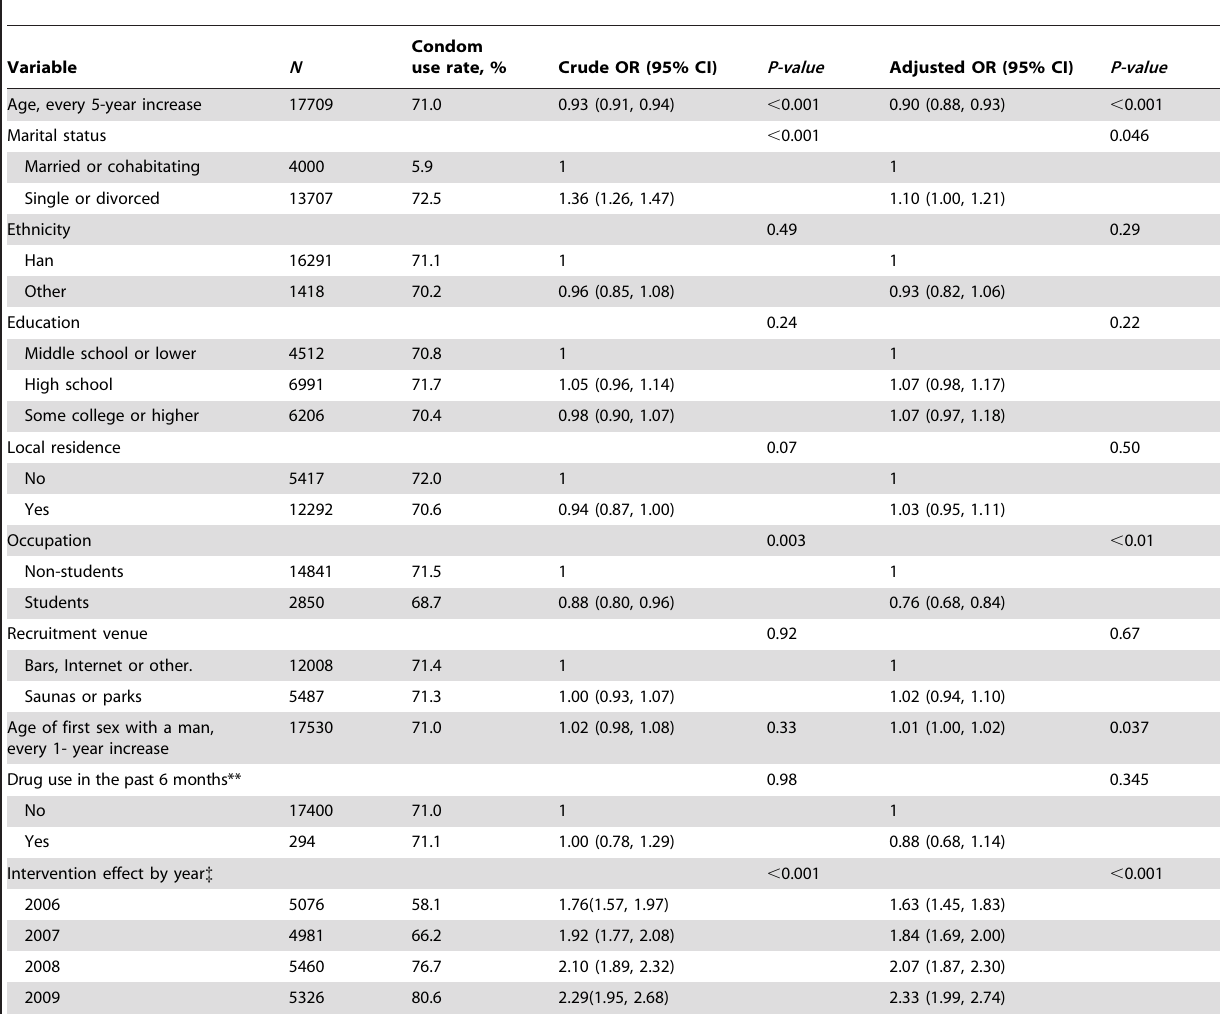
Table 6. Logistic regression of condom use at last sex with a male partner among MSM in 16 Chinese cities (surveys from all 4 years,